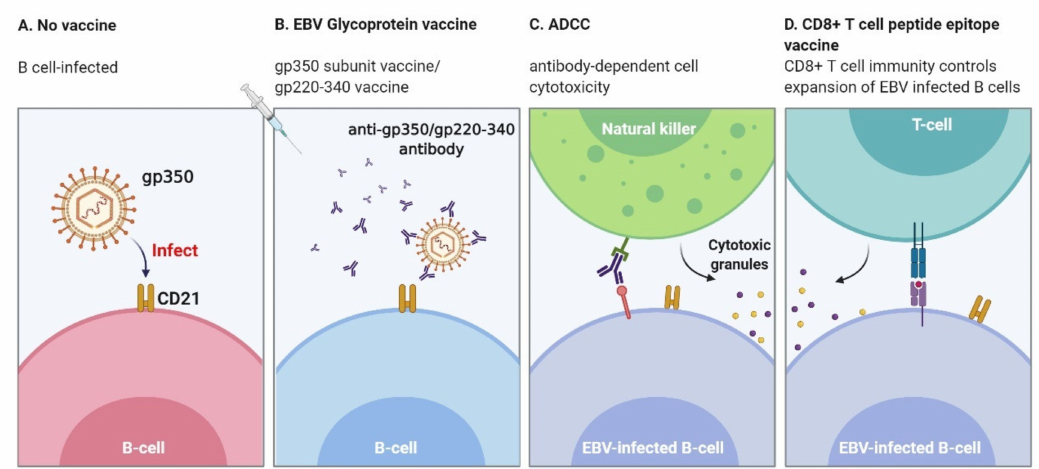
Figure 2. Mechanism of prophylactic vaccine action: ( A ) EBV virions bind to CD21 on B cells through gp350 and interact with HLA class II molecules to trigger gB-mediated viral–host membrane fusion within endosomes; ( B ) EBV membrane antigens are used as immunogens, and trigger neutralizing antibodies targeting virus particles to prevent the infection of host B cells; ( C ) the binding of antibodies with glycoprotein on the surface of infected cells can be recognized and eliminated by NK cells; ( D ) EBV-infected cells are recognized by T cells, which release cytotoxic granules and trigger the apoptosis of infected cells. Figure created with